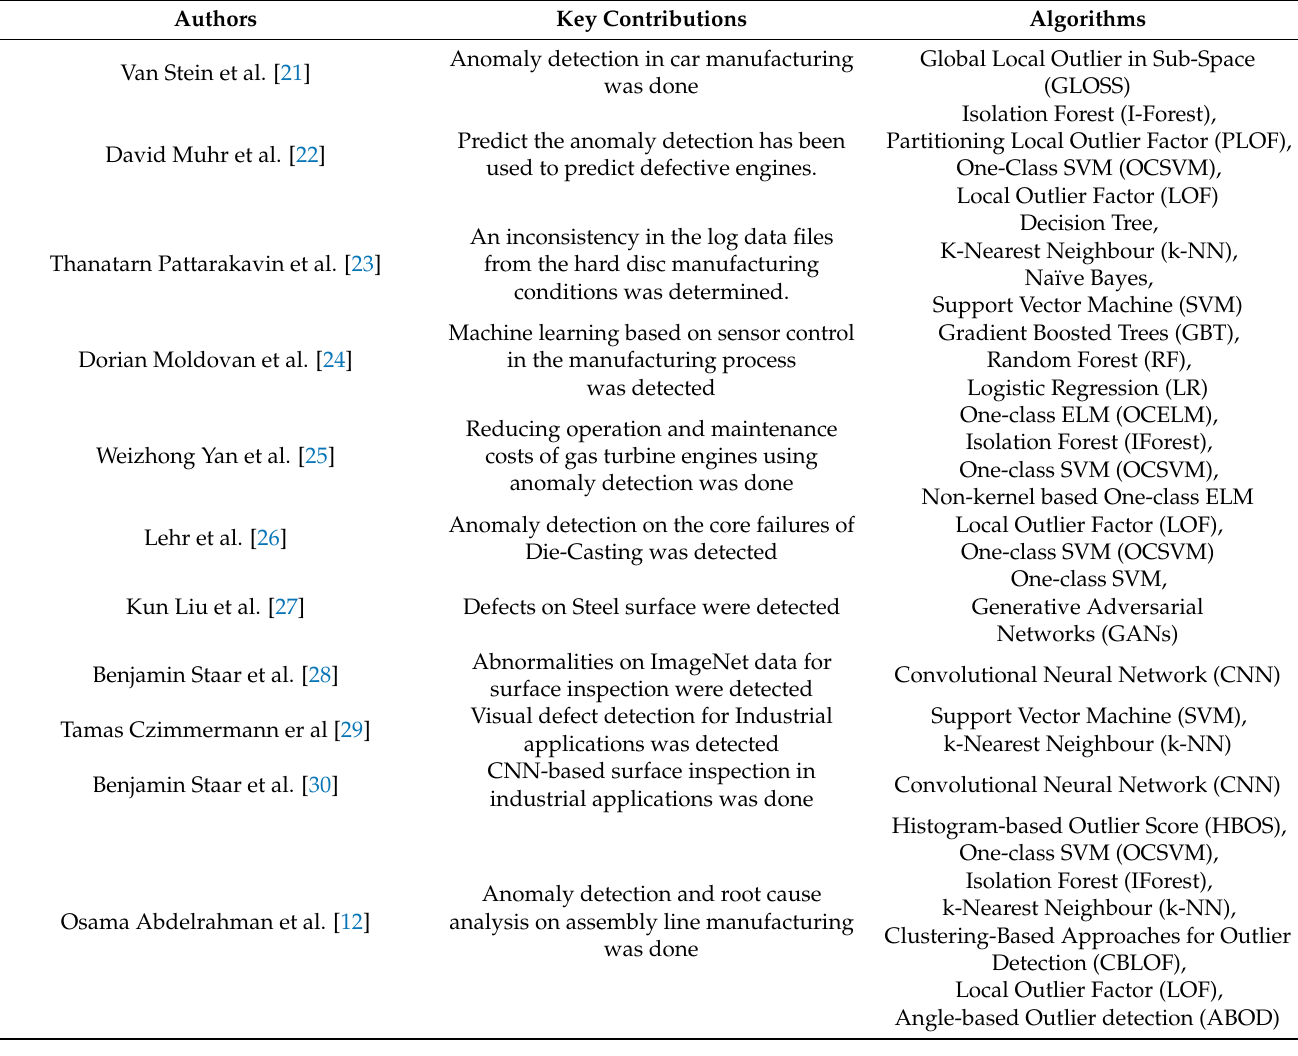
Table 1. Various algorithms are used in production processes regarding machine